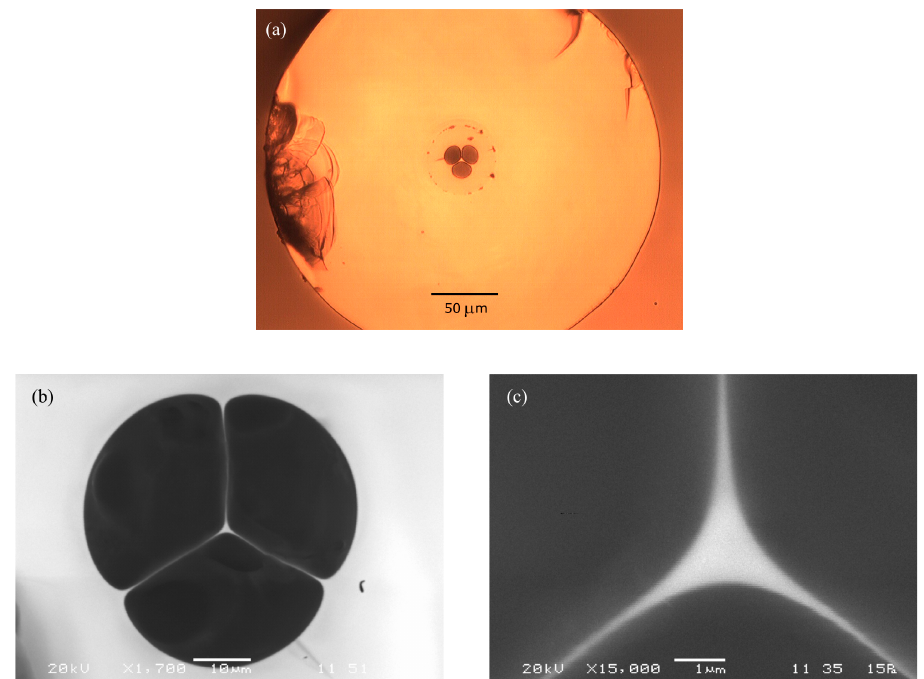
Figure 4. ( a ) Cross-section of MS fiber obtained with optical microscope. Cross section of the central part of MS fiber ( b ) and fiber core ( c ) obtained with electron microscope. Light areas correspond to glass and dark areas correspond to air holes.